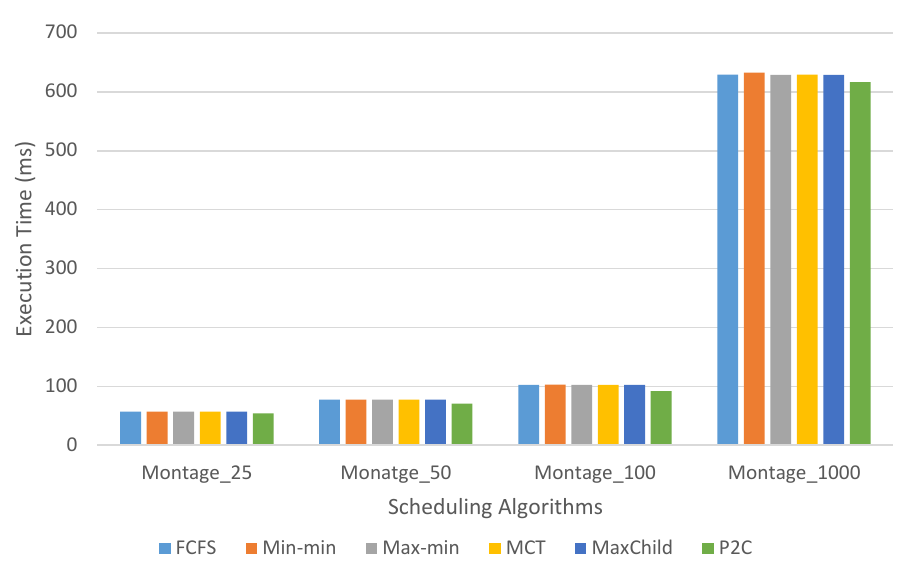
Figure 13. Comparison of execution time for montage workflow.